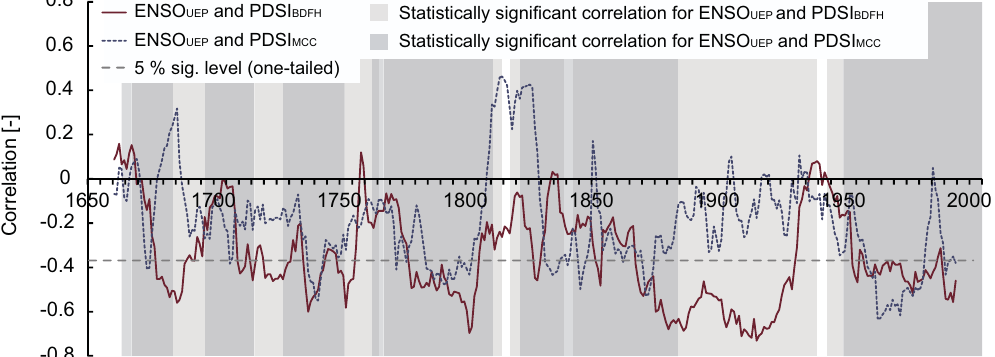
Figure 4. Correlations between ENSO UEP and PDSI BDFH and ENSO UEP and PDSI MCC using a 21-year moving window over the period of 1650–2004. PDSI data describe the hydroclimate of the March–May